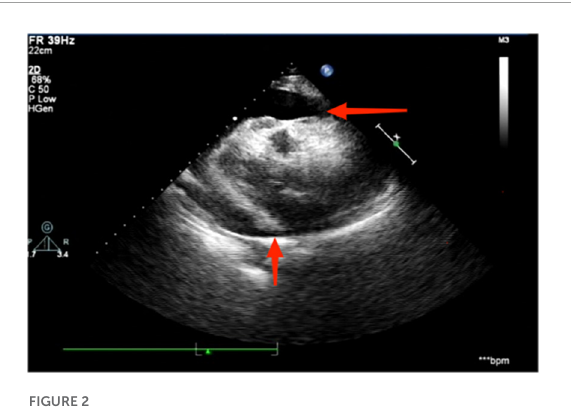
FIGURE2 Echocardiography suggests the presence of a moderate to large pericardial effusion, as indicated by the red